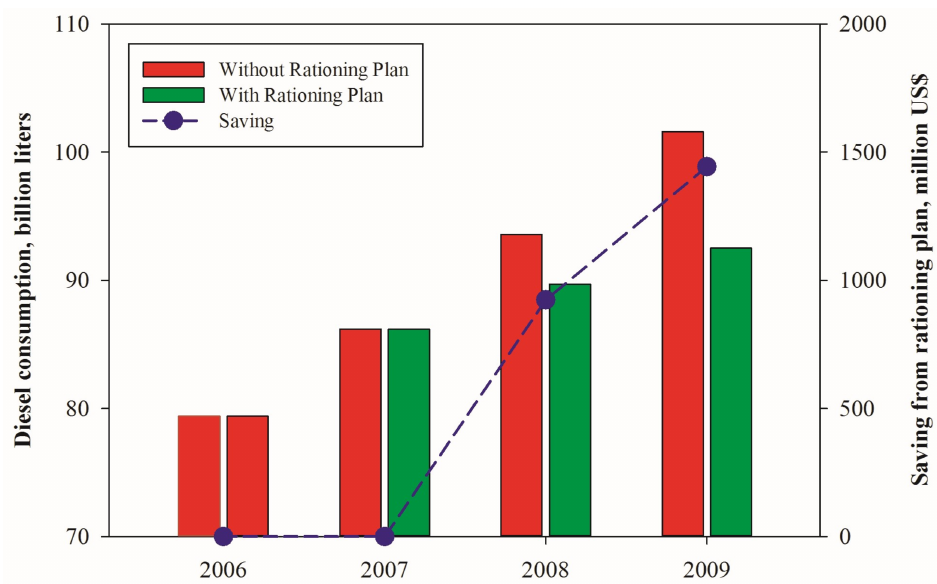
Figure 2. Effect of rationing plan on diesel consumption and